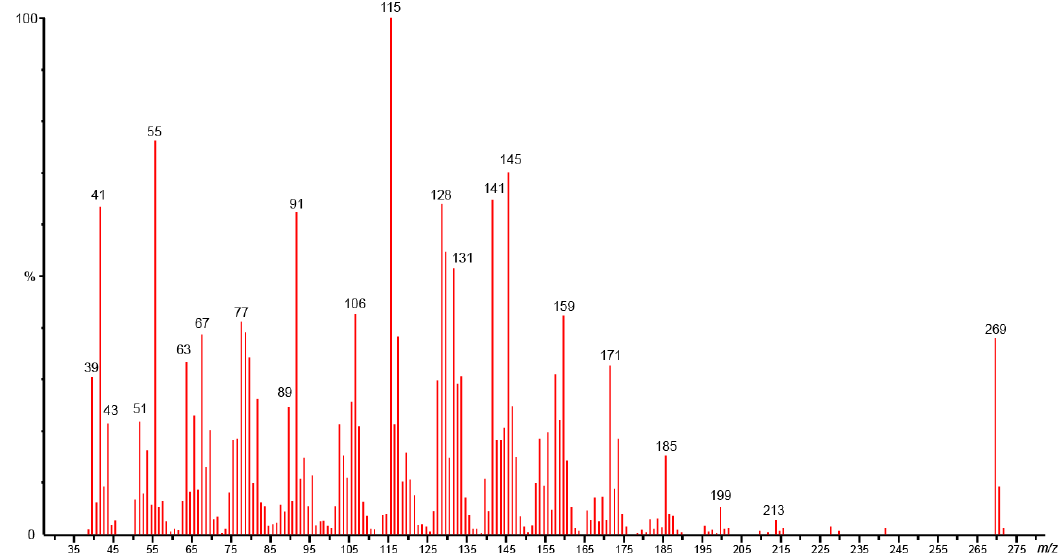
Figure 3. Electronic impact mass spectrum of campestrolide 33 (70 eV).